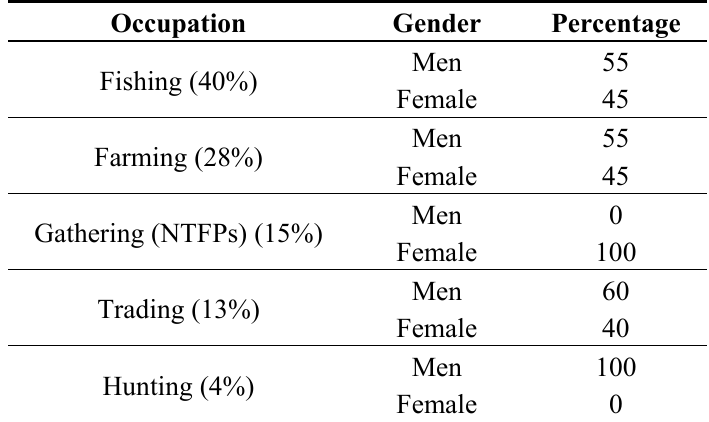
Table 2. Characteristics of respondents. Source: Akujuru and Ruddock